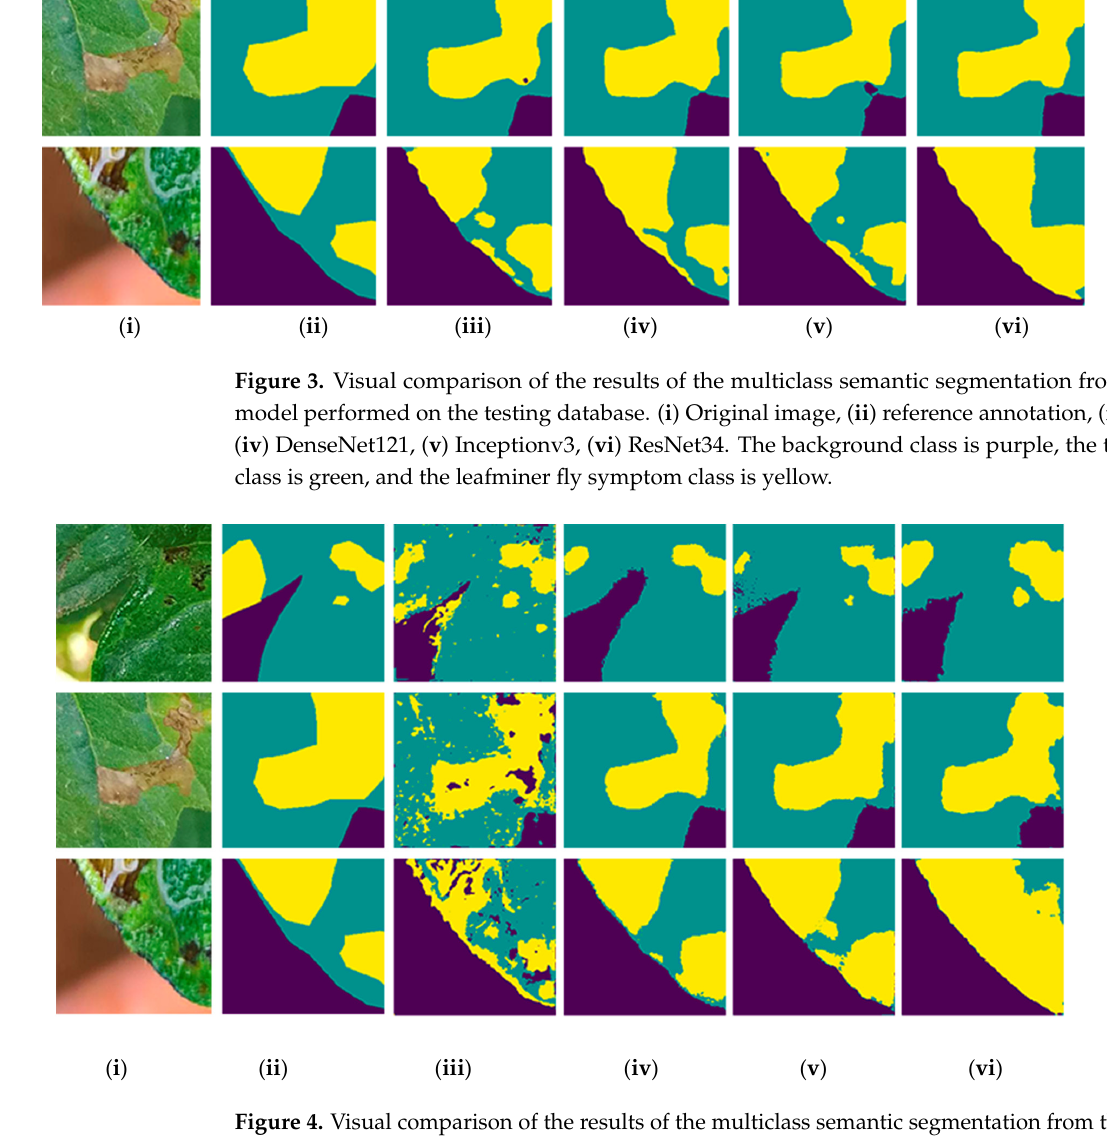
( iv ) DenseNet121, ( v ) Inceptionv3, ( vi ) ResNet34. The background class is purple, the tomato leaf class is green, and the leafminer fly symptom class is yellow.